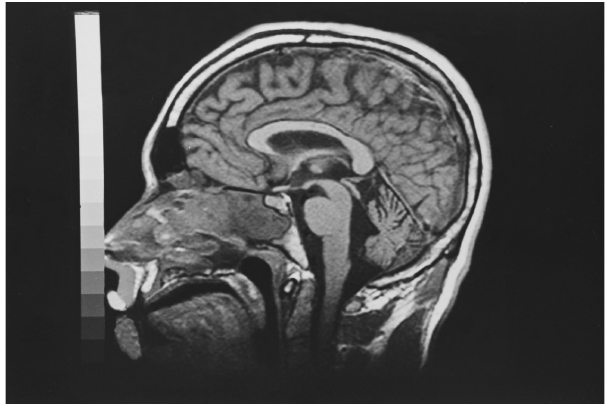
Figure 1 - Brain MRI sagittal section in T1, showing mild cerebellar atrophy in a patient with